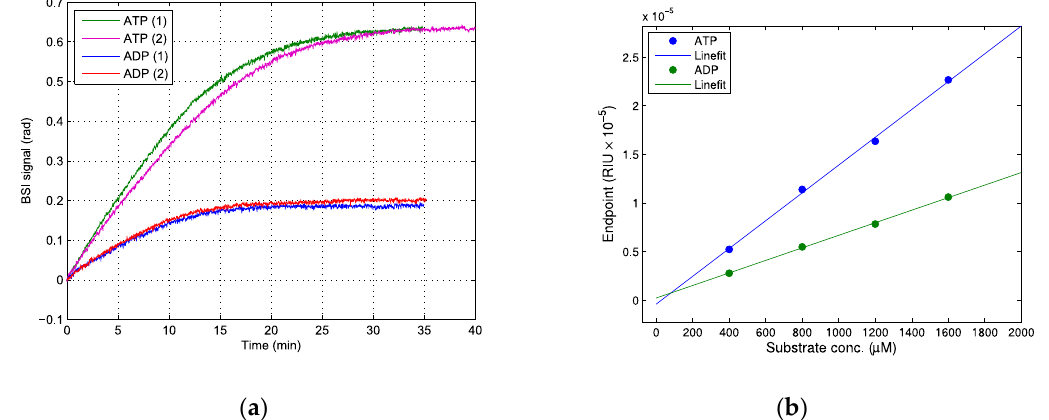
Figure 3. The enzymatic hydrolysis of ATP and ADP to AMP by apyrase. ( a ) The real-time measurement of 1.6 mM ATP and ADP (duplicate runs are shown for both ATP and ADP). ( b ) The linear fit of end-point values in refractive index units vs. initial substrate concentration. ATP (blue) R 2 > 0.99, slope 1.51 × 10 − 5 RIU/mM, ADP (green) R 2 > 0.99, slope 0.68 × 10 − 5 RIU/mM.